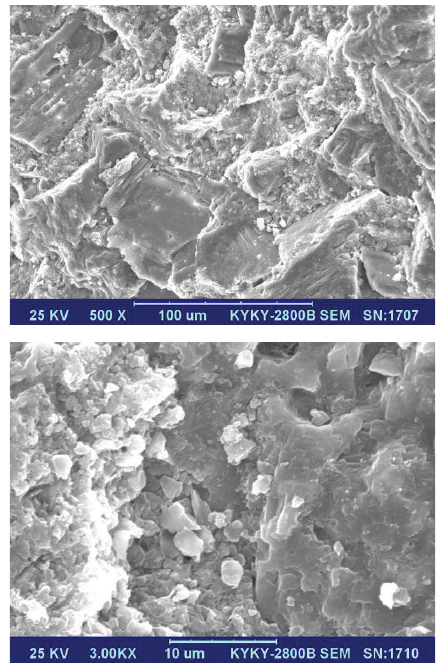
Figure 1: SEM images of Gu